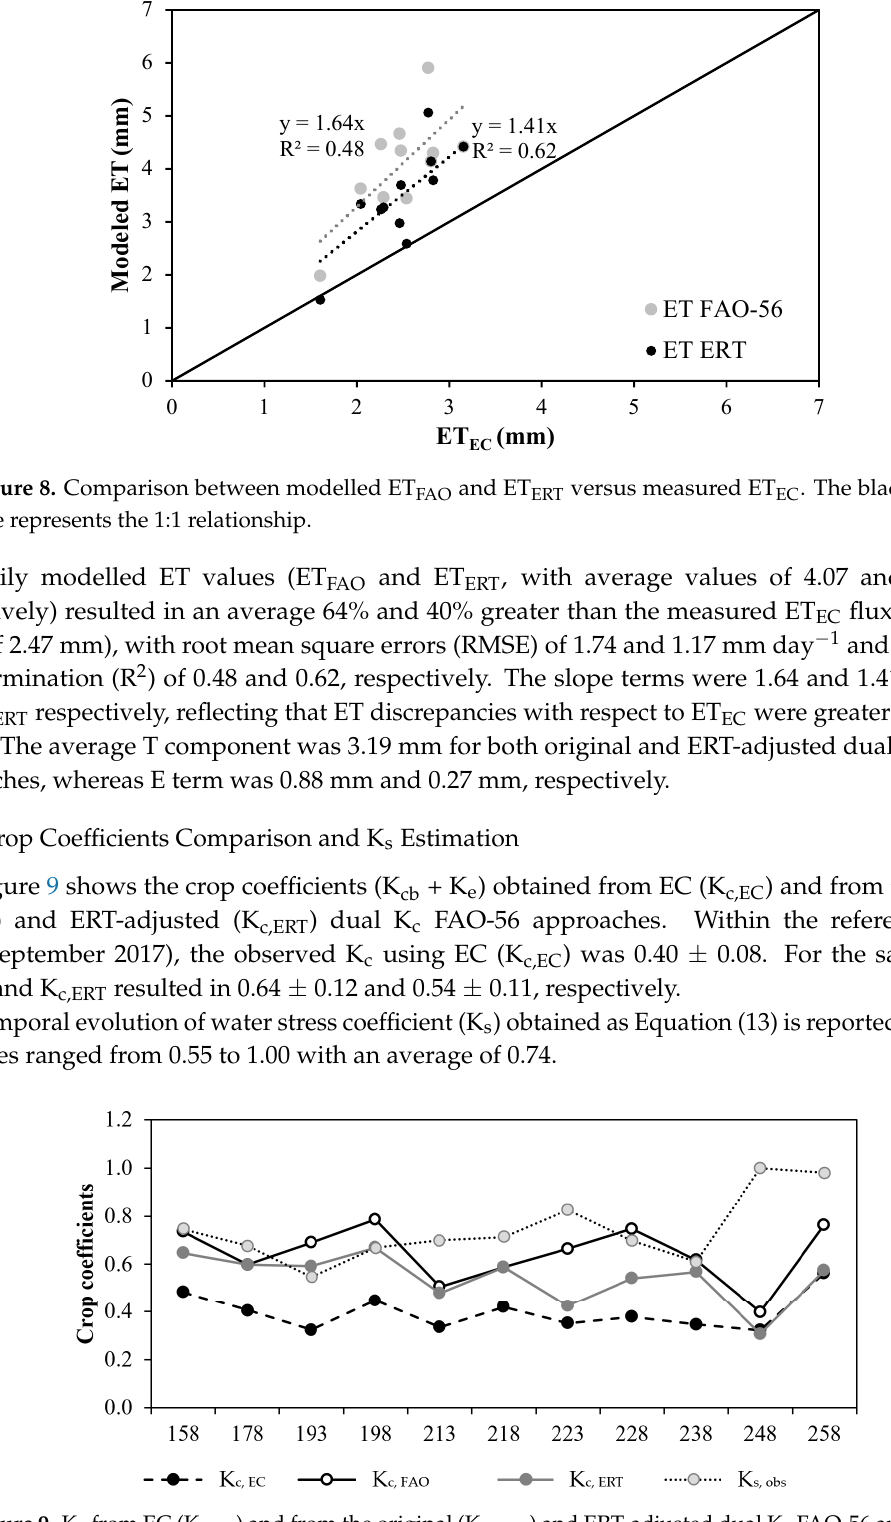
Figure 9. K c from EC (K c, EC ) and from the original (K c, FAO ) and ERT ‐ adjusted dual K c FAO ‐ 56 approach (K c, ERT ), and K s derived from ET EC and ET ERT